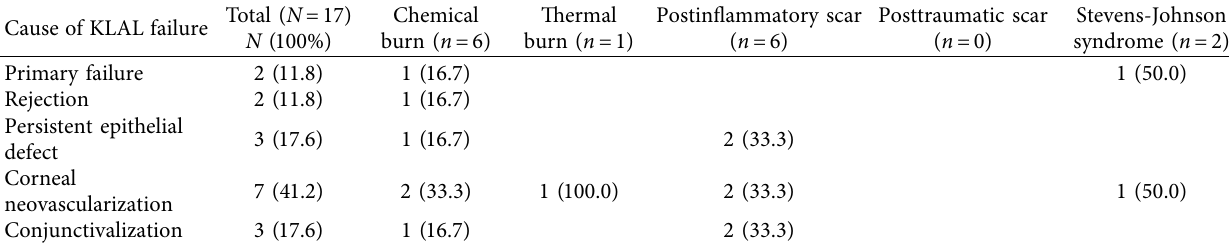
Table 2: Characteristics of primary KLAL